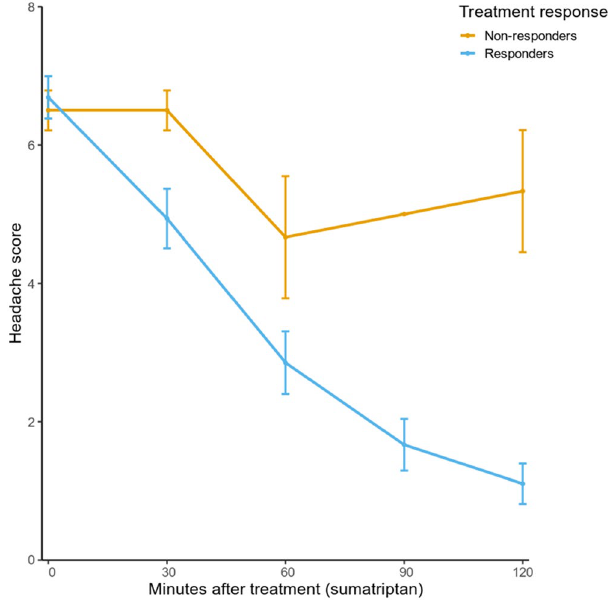
Figure 3. Difference in headache during the two hours after treatment with sumatriptan.